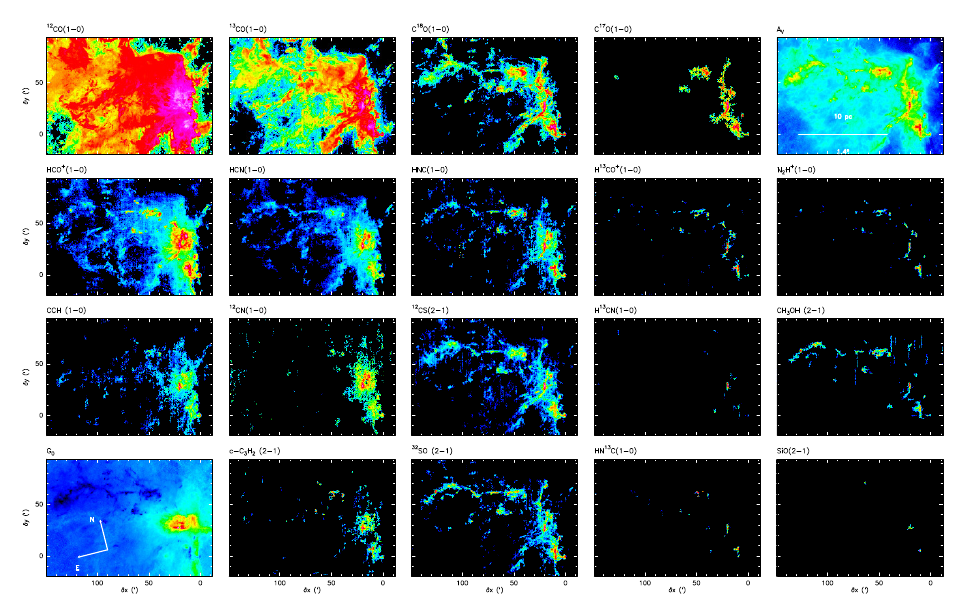
Figure 1. Spatial distribution of the line peak intensity of selected lines in the 3mm band, plus the dust temperature (bottom left panel) and visual extinction (top right panel) . Continuum data comes from the publicly available analysis of the Herschel Gould Belt Survey data (PI: P. André) [1]. Only reliably detected pixels are shown. The color-scales are logarithmic to reveal the distribution of faint signal.